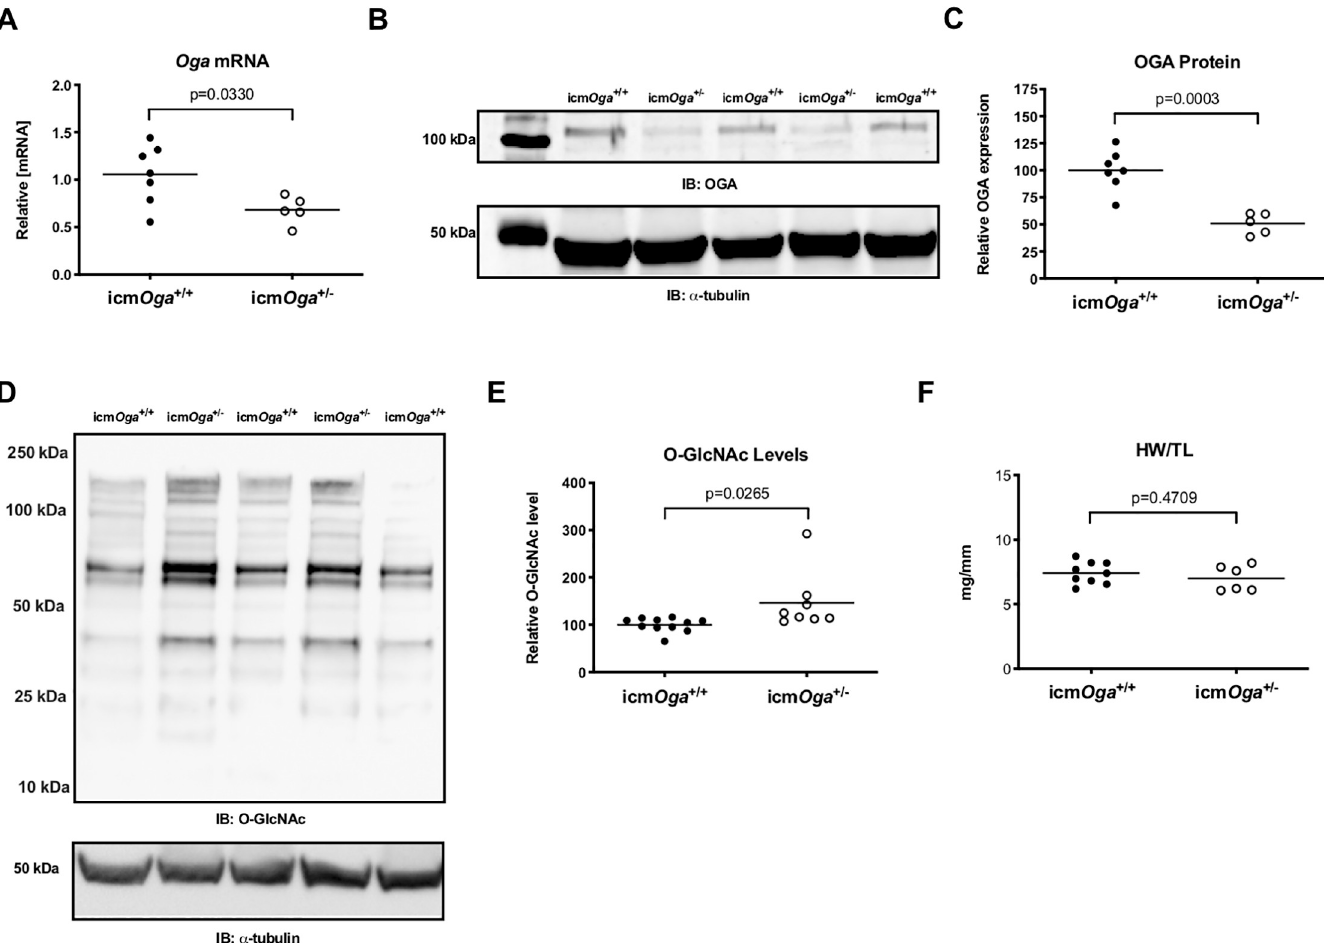
Fig 1. Oga deficiency induces elevated cardiac protein O-GlcNAcylation. Cardiac tissue from na ï ve male icm Oga +/+ (n = 5) and icm Oga +/- (n = 7) mice was harvested at 12–20 wk of age. Cardiac Oga mRNA expression (A). Immunoblot (B) and densitometric analysis (C) of OGA protein expression. Western blot for protein O-GlcNAcylation in icm Oga +/+ and icm Oga +/- hearts (D) and densitometric analysis (E). Gravimetric analysis of heart weight to tibia length (F). An unpaired Student’s t -test was used to determine significance between icm Oga +/+ and icm Oga +/- groups.